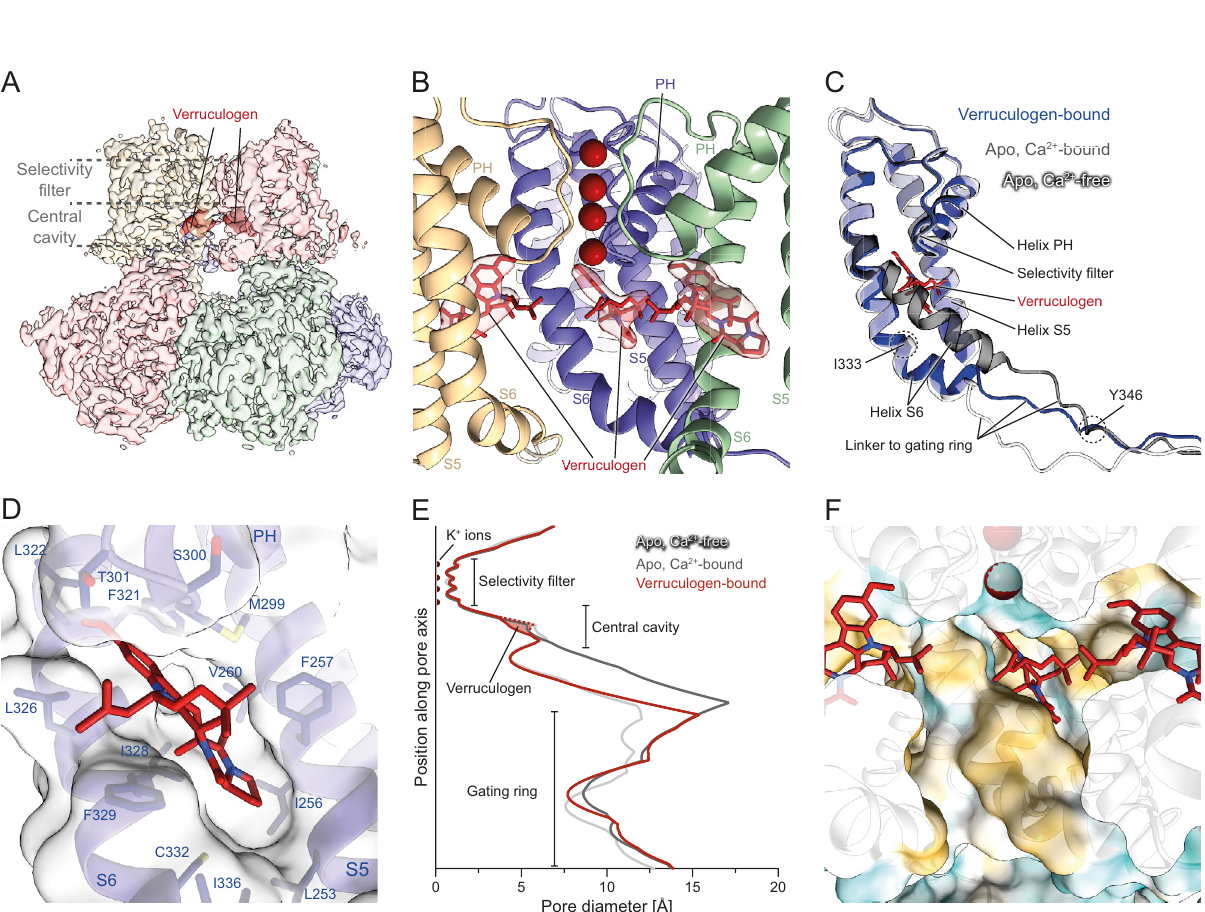
Fig. 4 Verruculogen restricts access to the ion-conducting pore. A Cryo-EM reconstruction of verruculogen-bound Slo colored by the macromolecular chain. Verruculogen molecules are shown as dark red surfaces. The position of the cavity and the selectivity fi lter are indicated by dashed lines. B View of the verruculogen-bound cavity shown from the side. One of the four macromolecular chains was omitted to allow an unobstructed view into the internal pore. The corresponding verruculogen molecules (red) are shown as sticks and are surrounded by the experimental Coulomb potential map (faint red). Verruculogen binds into a pocket between helices S5 and S6 and the turn between the PH helix and the selectivity fi lter. C Superposition of the hinge helix S6 conformation in the verruculogen structure (blue) with both apo structures (gray). When verruculogen is bound, helix S6 follows a trajectory that is almost identical to the Ca 2 + -free conformation since the position of the Ca 2 + -bound conformation would clash with verruculogen. This is compensated by a stronger kink around residue I333 and a more extended conformation of the linker which joins the Ca 2 + -bound conformation around Y346. D Closeup view of the verruculogen binding site showing the exact fi t of verruculogen into the pocket. The cavity is lined predominantly by hydrophobic residues of helices S5 and S6 as well as the turn C-terminal of helix PH. E Pore diameter plot of the verruculogen-bound conformation (red) as well as both apo states (gray). The red dashed line indicates the pore diameter of the verruculogen-bound conformation with verruculogen omitted from the structure, and the light red area the contribution of verruculogen to the narrower pore. Verruculogen induces a Ca 2 + -free-like diameter of the cavity. F Surface representation of the pore around the verruculogen-bound cavity colored in a gradient from cyan over white to yellow according to increasing molecular lipophilicity potential (MLP). Half of the Slo tetramer was omitted to allow an unobstructed view into the internal pore. The exposed hydrophobic face of helix S6 appears even more dominant and, along with the aliphatic tail of verruculogen pointing into the cavity, results in an overall very hydrophobic